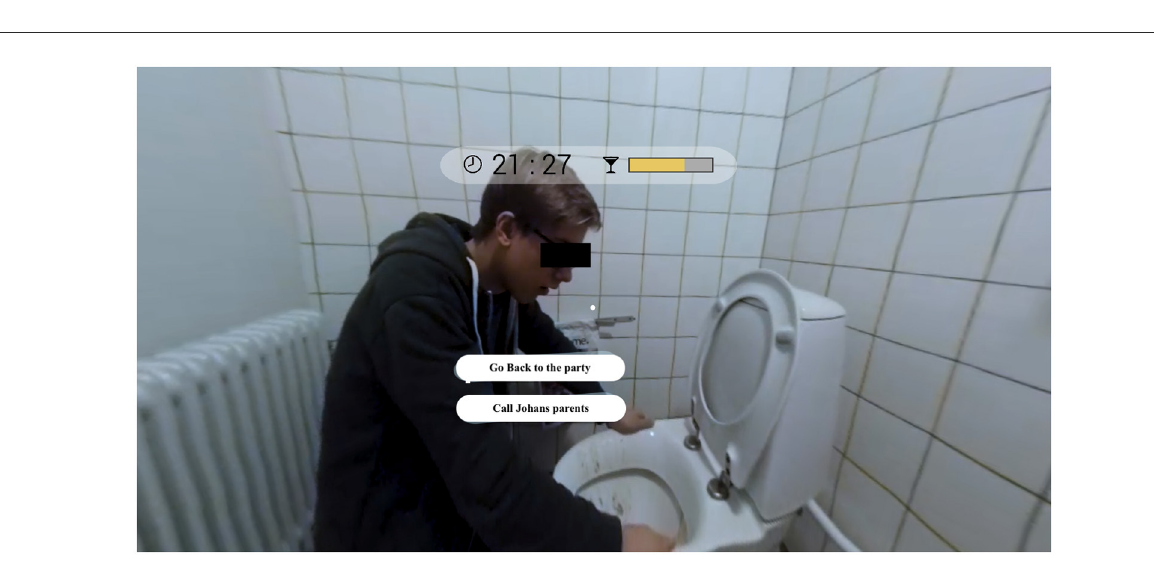
FIGURE2 Screenshot of the VR simulation in which the user needs to decide whether to support another party guest text translated to